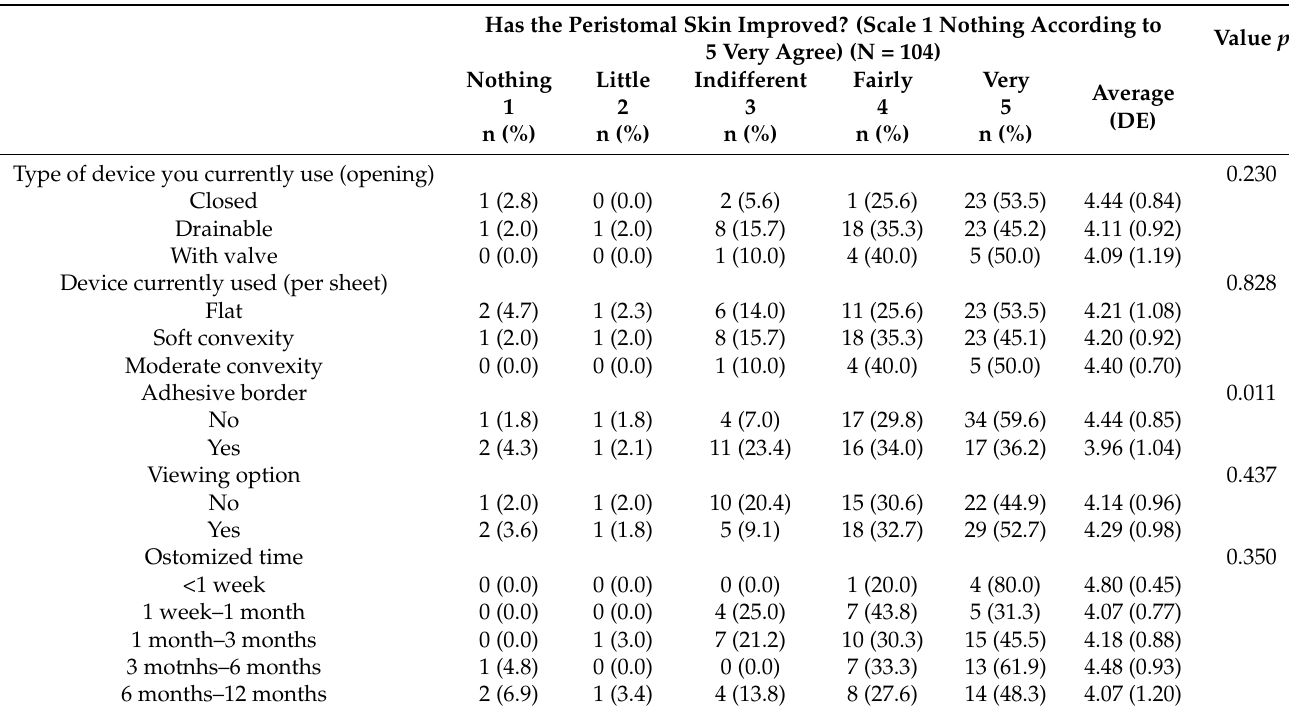
Table 7. Evaluation of the improvement of peristomal skin in patients with damaged and irritated skin according to the type of device and some